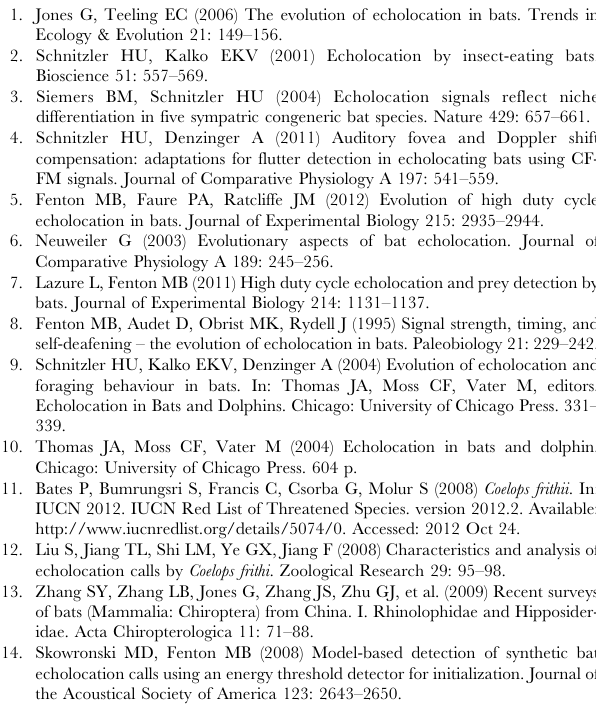
Table S1 Summary of Coelops frithii echolocation call parameters measured in various settings, and results of MANOVA tests. Approach: bats that approached the fluttering target positioned outside the roost. No approach: bats that did not approach the fluttering target. Entrance: bats flying through the ceiling of the roost. (mean on top, and SD on bottom). Table S2 Summary of Coelops frithii echolocation call parameters measured from males and females, and results of MANOVA tests between sexes. (mean on top, and SD on